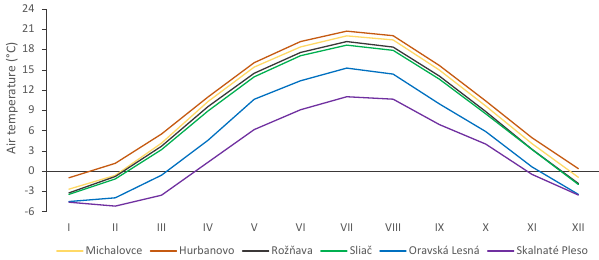
Figure 2. Annual cycle of the temperature at stations used in the